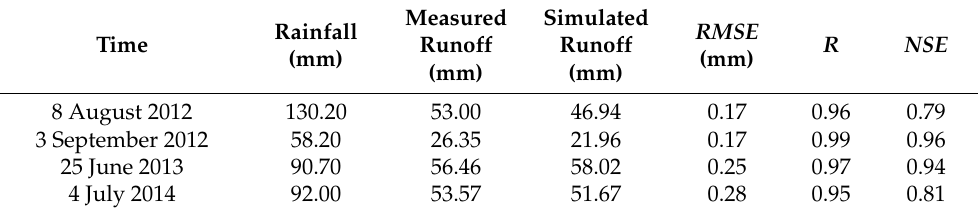
Figure 7. Scatter plot of simulated and measured runoff values in the calibration period. Table 6. Statistical indexes for the performance of the paddy field runoff model. (calibration period, ∆T = 1 h).